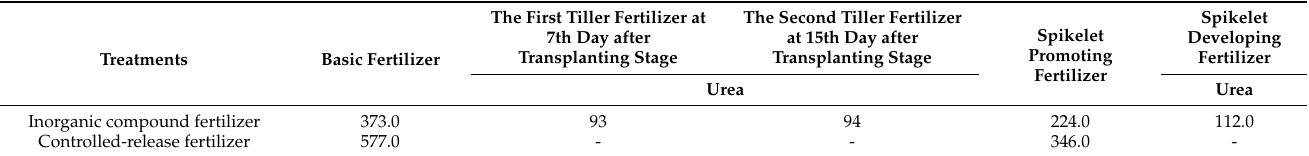
Table 1. At transplanting stage, the machine insertion mode and deep fertilization were adopted, where a trench was dug at a depth of 5 cm and at a distance of 4 cm away from one side of the seedlings, and then fertilizer was spread evenly over the trench. Conventional rice farming without N fertilizer and rice–crayfish coculture without N fertilizer were used as auxiliary experiments. Table 1. Fertilizer management in rice–crayfish coculture and conventional rice farming (kg · ha − 1 ). The First Tiller Fertilizer at The Second Tiller Fertilizer 7th Day after at 15th Day after Transplanting Stage Treatments Basic Fertilizer Inorganic compound